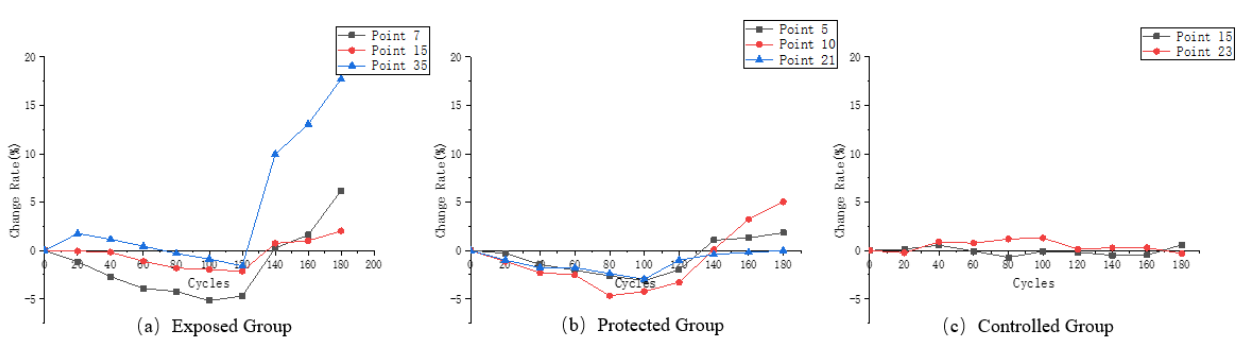
9 of 18 Figure 6. ( a ) Ultrasonic velocity variation rate of the characteristic measurement points of the ex- posed group; ( b ) ultrasonic velocity variation rate of the characteristic measurement points of the